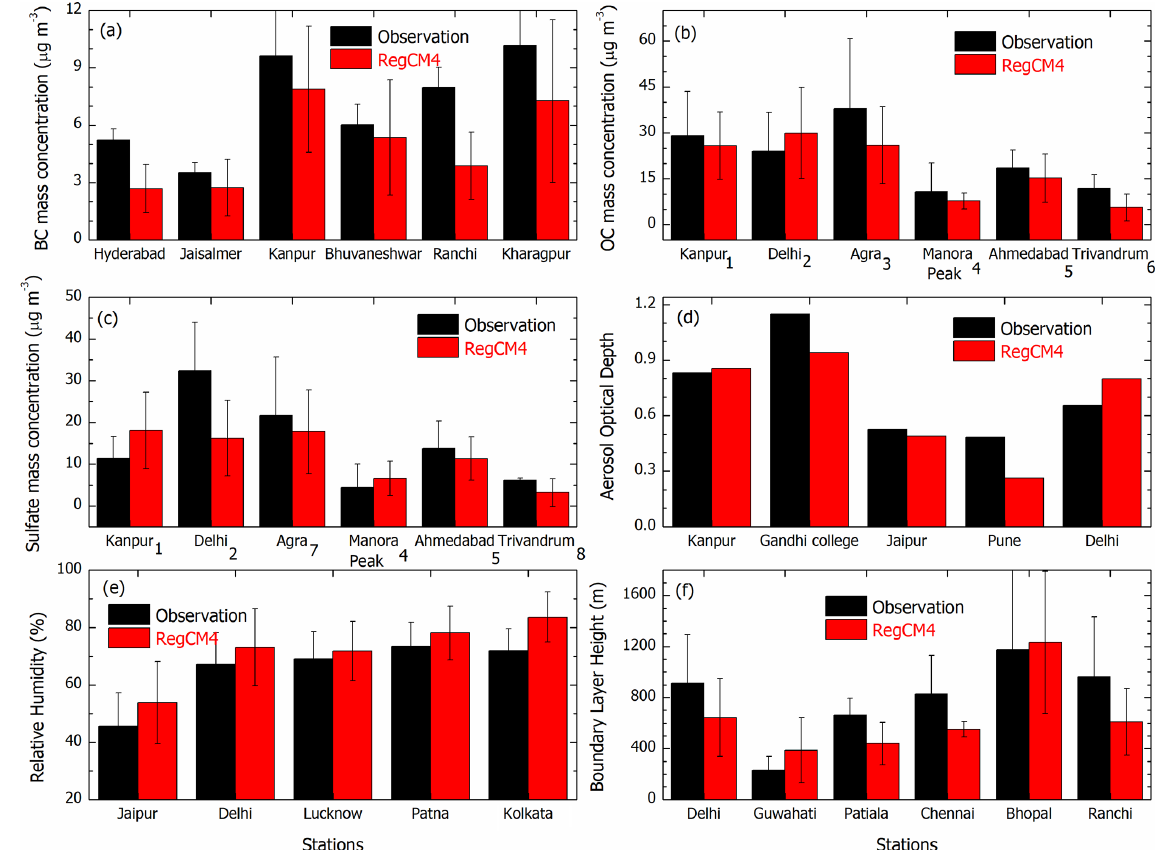
Figure 2. Validation of RegCM4-simulated (Exp3) aerosol parameters ( a , black carbon – BC; b , organic carbon – OC; c , sulfate; d , AOD), (e) relative humidity and (f) boundary layer height with measurements over different locations in India. The measurements of OC and sulfate mass loading are taken from earlier measurements (Kanpur 1 – Ram et al., 2012; Delhi 2 – Ali et al., 2019; Agra 3 – Satsangi et al., 2012; Manora Peak 4 – Ram et al., 2010; Ahmedabad 5 – Rengarajan et al., 2011; Trivandrum 6 – Aswini et al., 2019; Agra 7 – Safai et al., 2008; Trivandrum 8 – George et al., 2008), and these values represent the winter season but for different years than those of the model